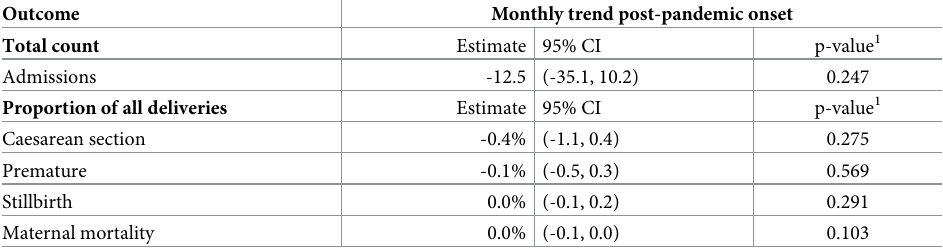
Table 2. Change in monthly trend in service delivery and adverse birth outcomes in the period post pandemic onset, controlling for the strike (December 2020 –February